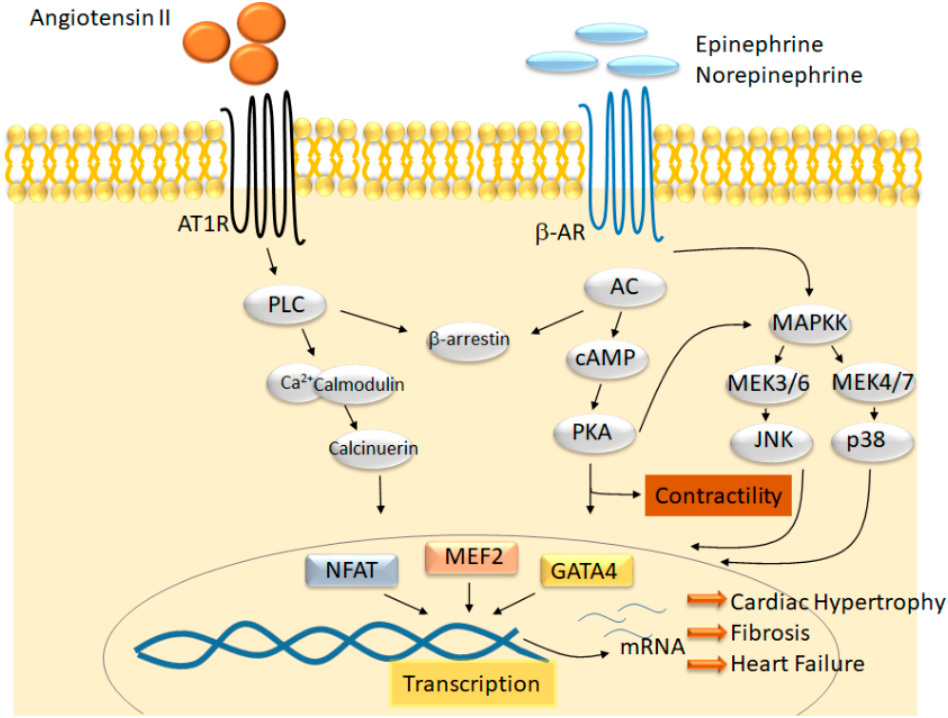
Figure 1. Neurohormonal signaling cascades converge on gene transcription to promote HF. Diagram of cardiac stress signaling pathways and their downstream effectors that converge on the transcriptional machinery to promote the development of cardiac hypertrophy and fibrosis, leading to HF. Signaling cascades activate well ‐ known transcription factors, including the nuclear factor of activated T ‐ cells (NFAT), myocyte enhancer factor 2 (MEF2), and GATA ‐ binding protein 4 (GATA4), which are involved in pathological gene expression changes. AC, adenylyl cyclase; AT1R, angiotensin II receptor type 1; β‐ AR, beta ‐ adrenergic receptor; phospholipase C; PKA, protein kinase A.